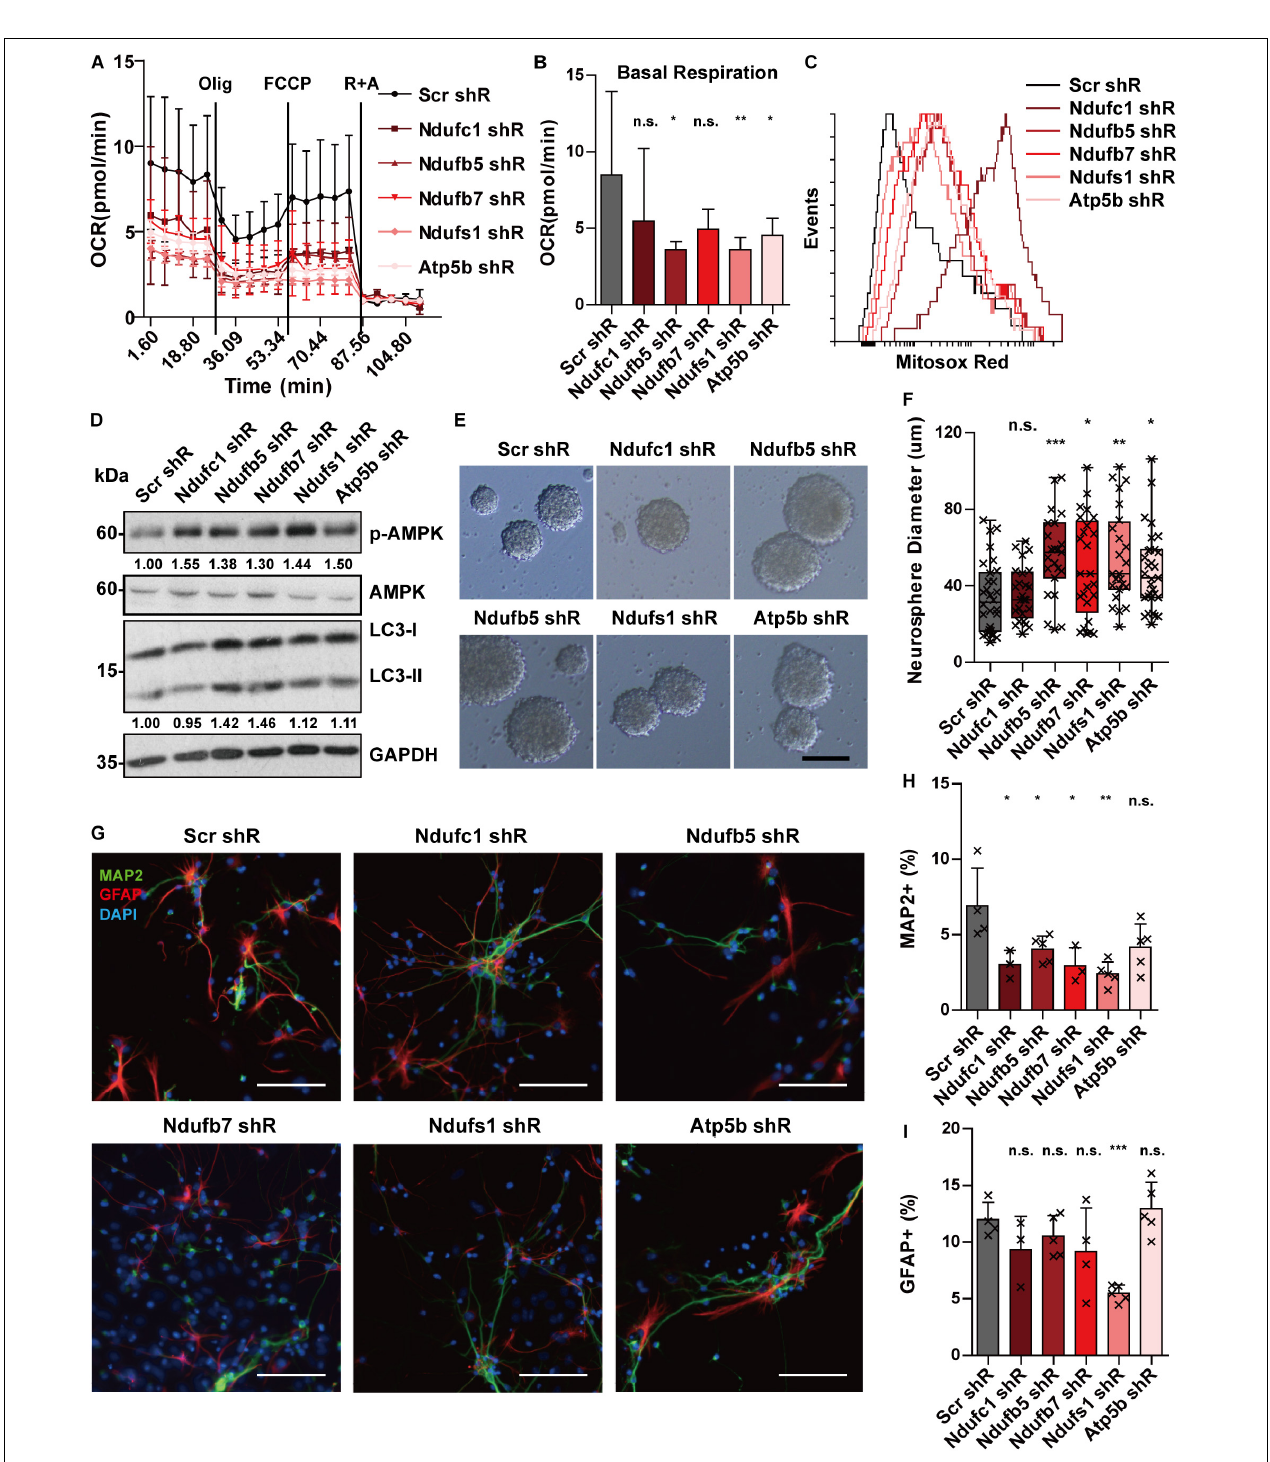
FIGURE 5 | Knockdown of OXPHOS genes mimics the phenotypes of Stat3 cKO. (A,B) Knockdown of OXPHOS genes downregulated OCR of neural progenitors. Error bars represent mean ± standard deviations. * p < 0.05, ** p < 0.01, *** p < 0.005, n.s. not significant. (C) Knockdown of OXPHOS genes promoted mitochondria superoxide production. (D) Knockdown of OXPHOS genes activated the AMPK pathway and the autophagy marker. (E–H) Knockdown of OXPHOS genes (except Ndufc1) led to a significantly higher proliferation rate of neural progenitors. Scale bar: 50 µ m. Box plot represents the median, maximum and minimum value as well as the interquartile range. Mann–Whitney U test was used to determine the statistical significance of the neurosphere size difference. * p < 0.05, ** p < 0.01, *** p < 0.005, n.s. not significant. (G–I) Knockdown of OXPHOS genes resulted in decreased neurons and astrocytes generation. Error bars represent mean ± S.E.M. Knockdown efficiency was validated by RT-qPCR ( Supplementary Figure S8 ).